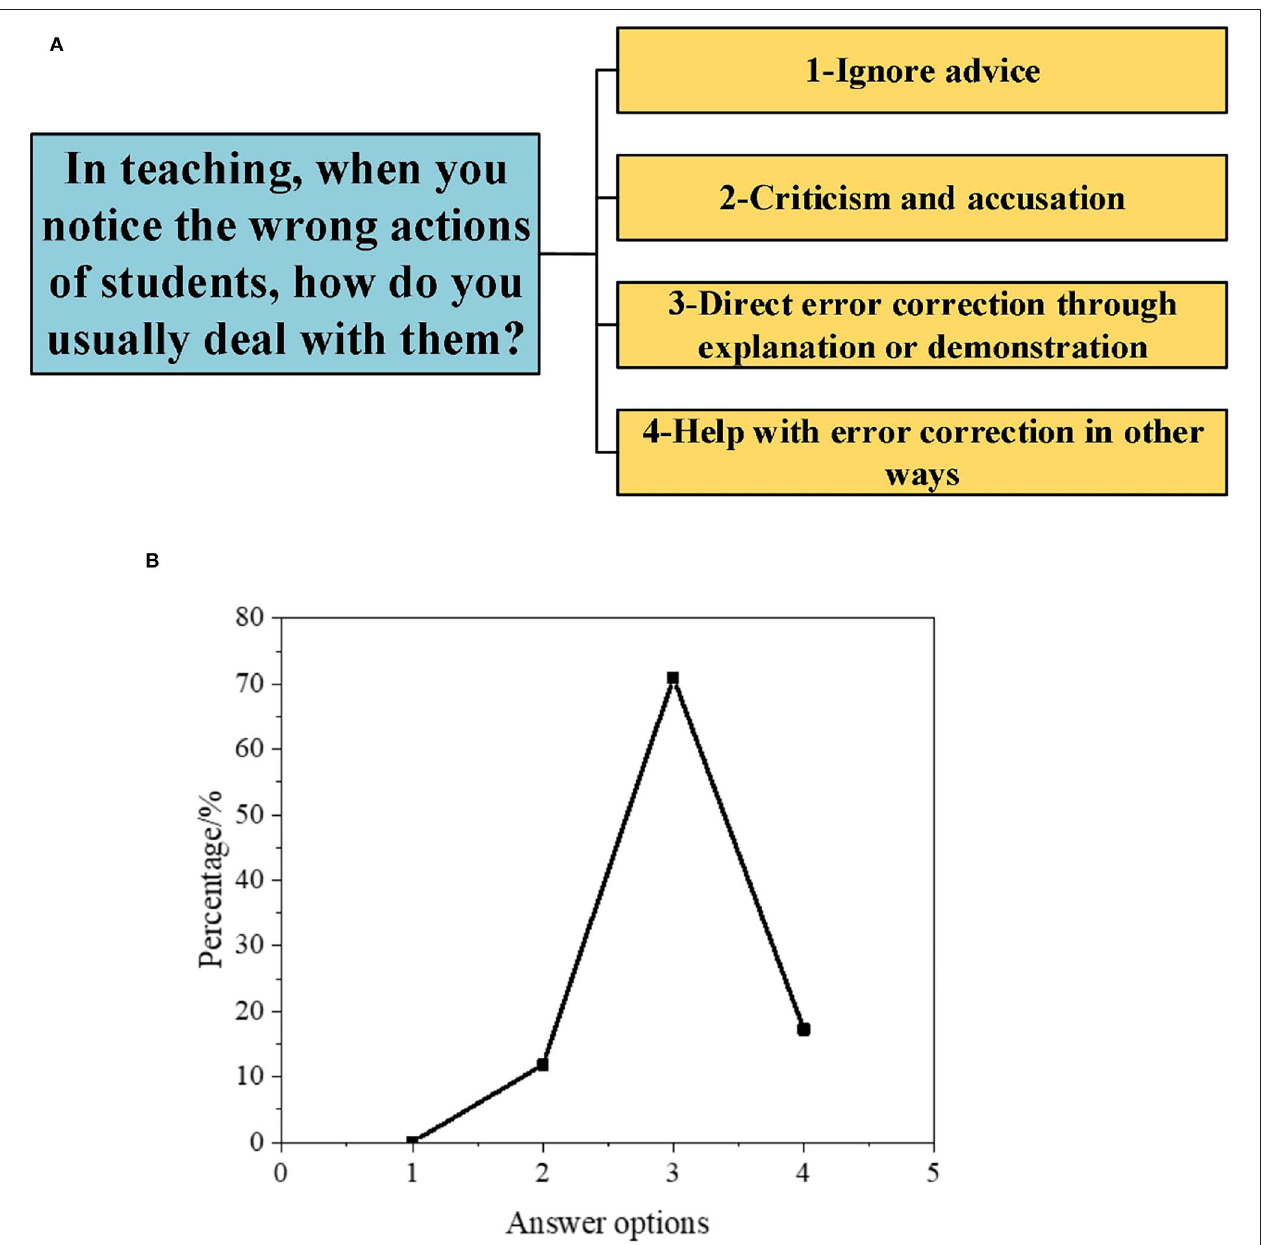
FIGURE 1 | Interview data on the DAU of students’ error-oriented GCR [ (A) : questions and options; (B) : proportion of